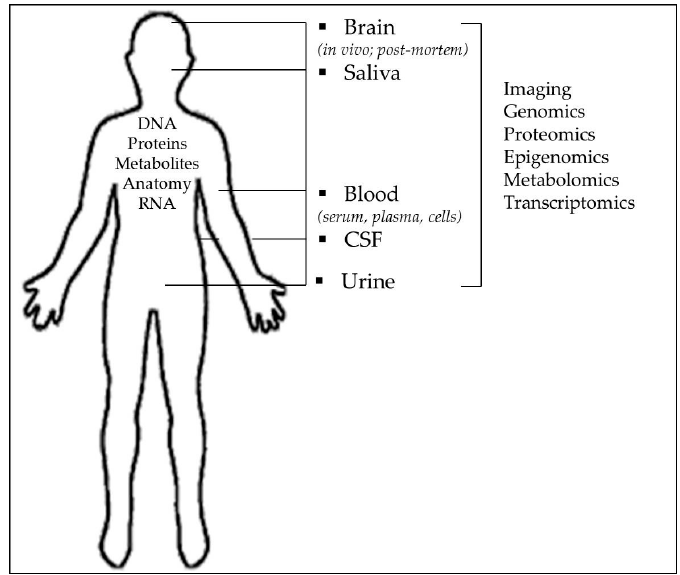
Figure 1. Biomarkers that can be measured or determined from the post-mortem brain or using in vivo neuroimaging studies, as well as from peripheral cells and easily available body fluids such as plasma/serum, urine or cerebrospinal fluid (CSF).